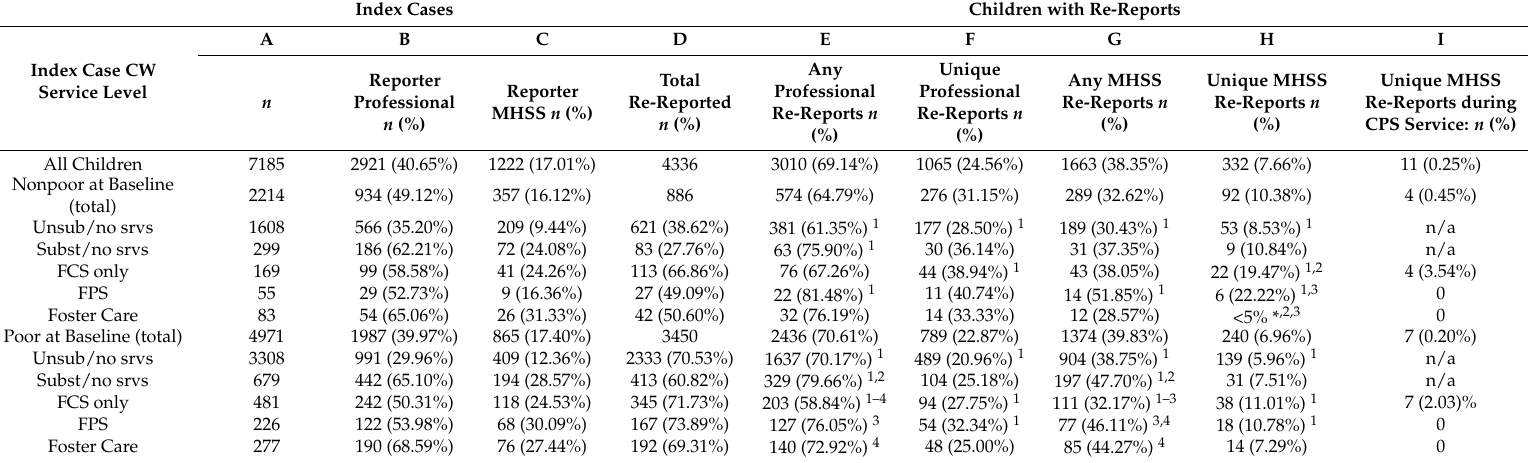
Table 2. CW service level at index by reporter type and re-reports by reporter type according to baseline poverty (Regional Data).